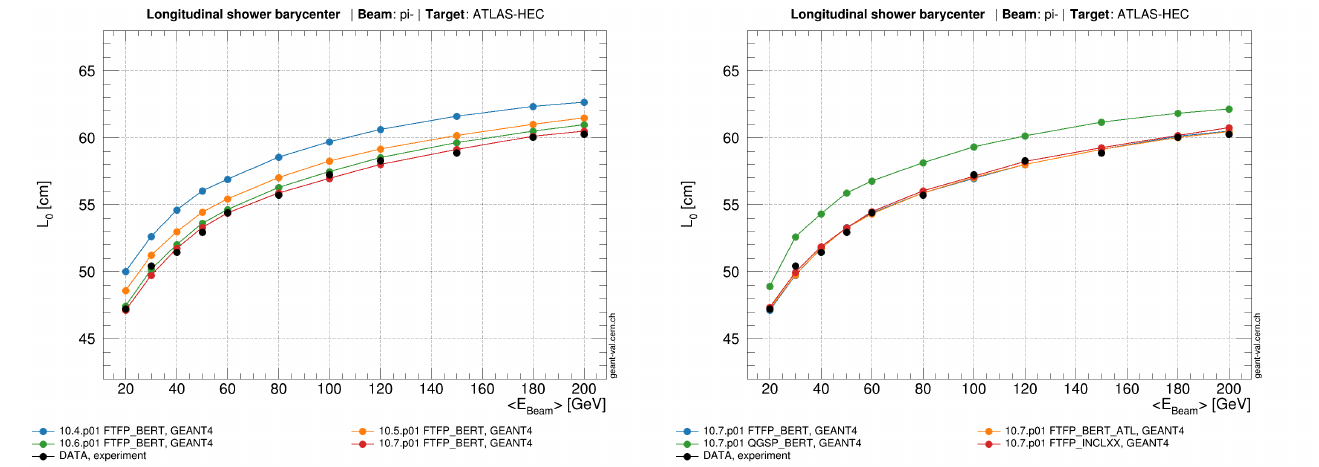
Figure 4. Left : L 0 comparison of the Geant4 FTFP_BERT PL prediction for recent releases (2017–2020) with the experimental data. Right : Comparison of several PL predictions from Geant4 10.7.p01 for the same